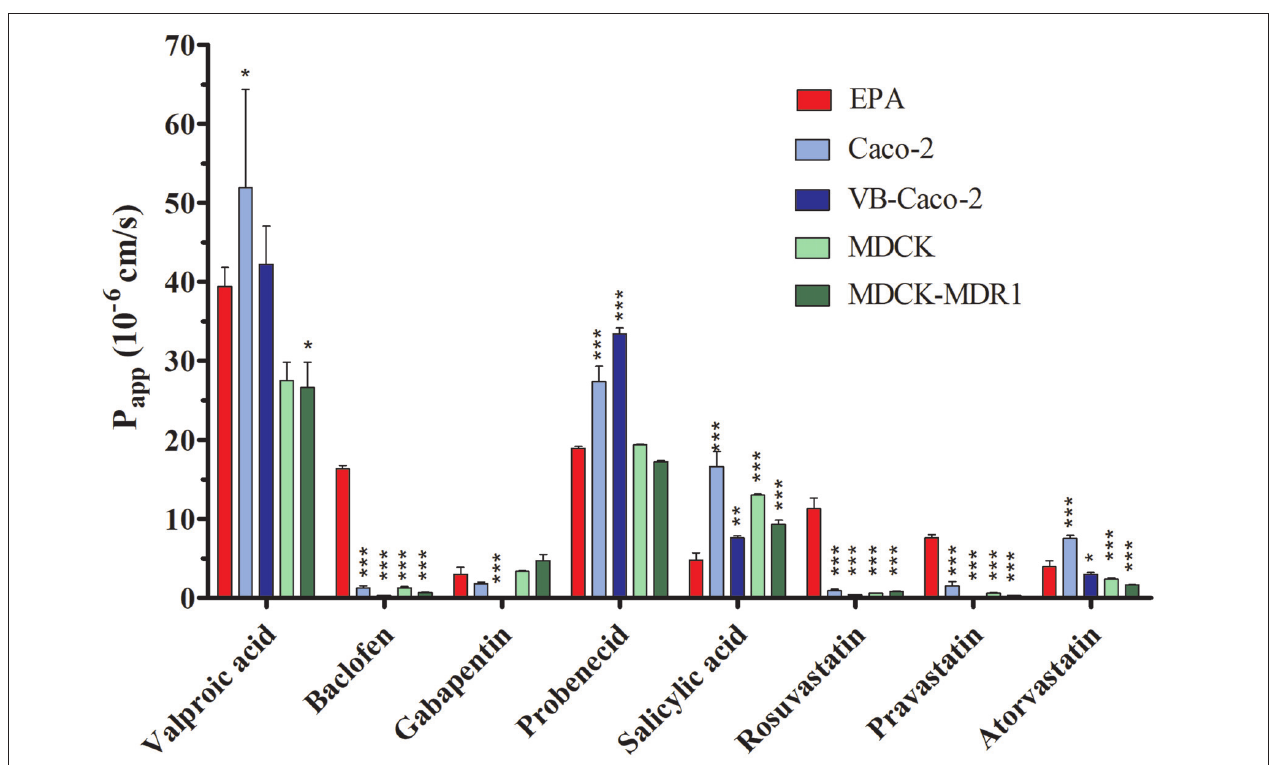
FIGURE 10 | Permeability coefficients (P app ) for selected drugs on primary rat brain endothelial cell-based BBB model (EPA) and in epithelial cell line models (Caco-2, VB-Caco-2, MDCK and MDCK-MDR1) measured in the apical to basal (blood-to-brain) direction. Statistics: mean ± SD, n = 4, ANOVA and Dunnett test; ∗ P < 0.05, ∗∗ P < 0.01; ∗∗∗ P < 0.001 compared to